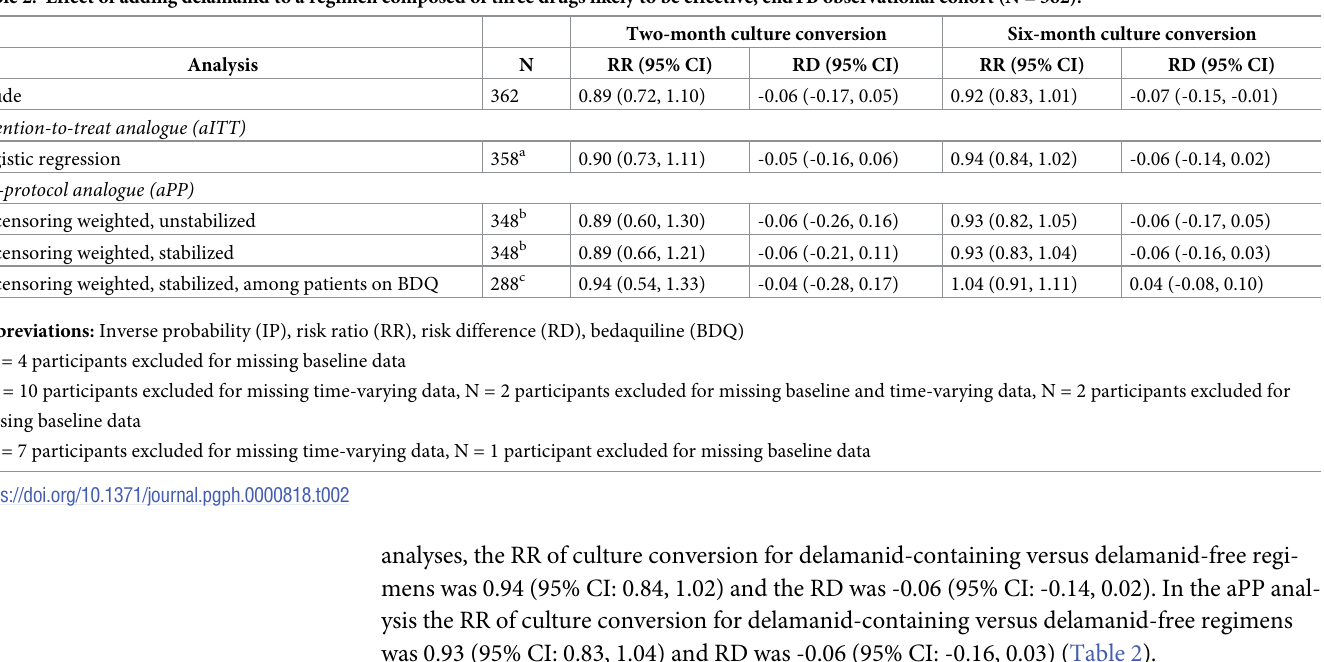
Table 2. Effect of adding delamanid to a regimen composed of three drugs likely to be effective, endTB observational cohort (N =